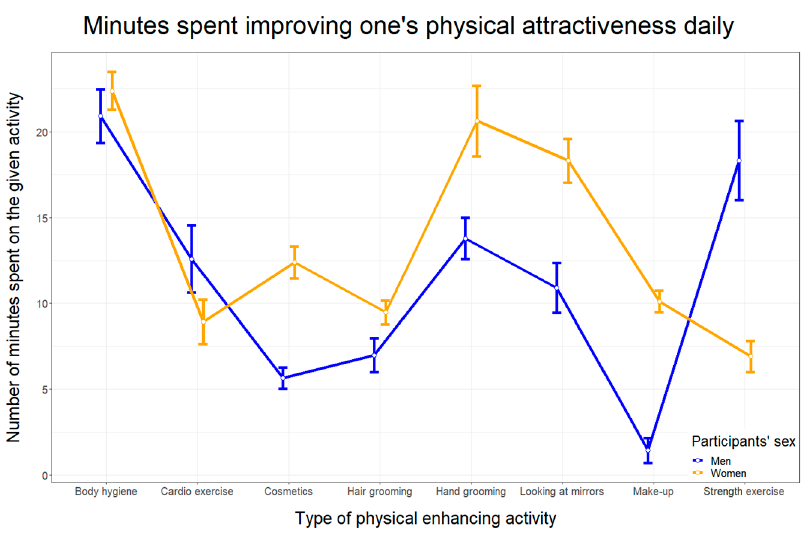
Figure 1. Means and standard errors of daily time spent performing each beauty-enhancing activity regarding participants’ sex.